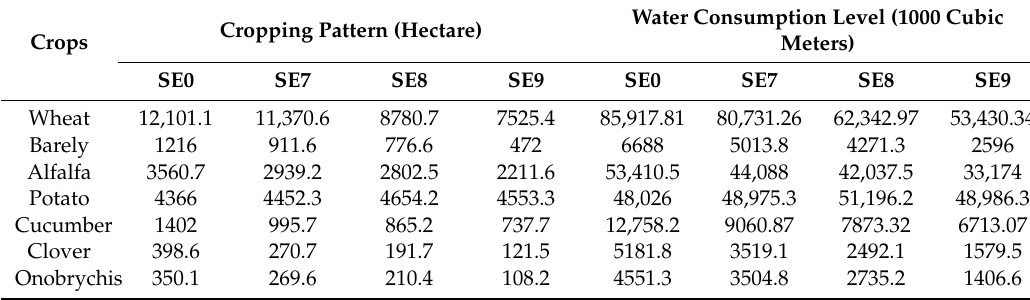
Table A3. Results of solving PMP model based on simultaneous scenarios of pricing and